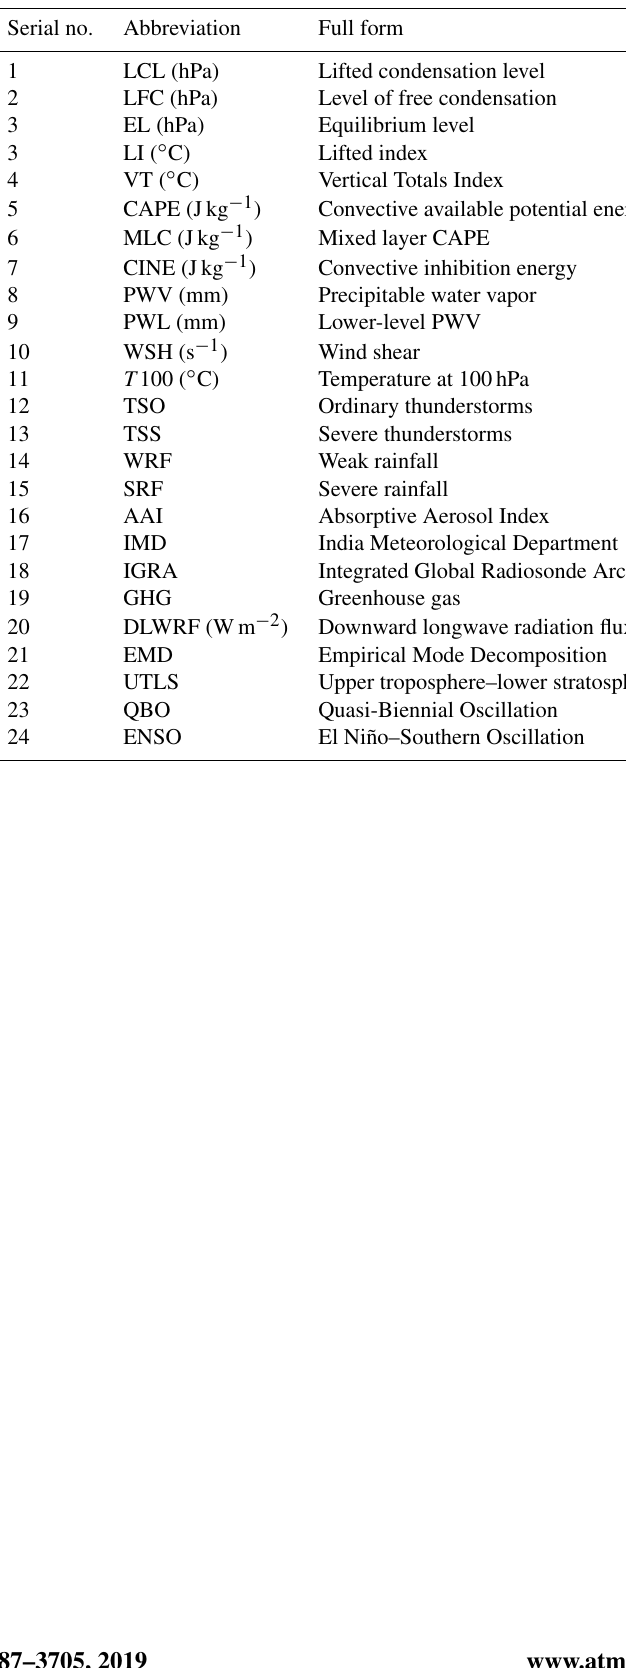
Table A2. List of abbreviations.